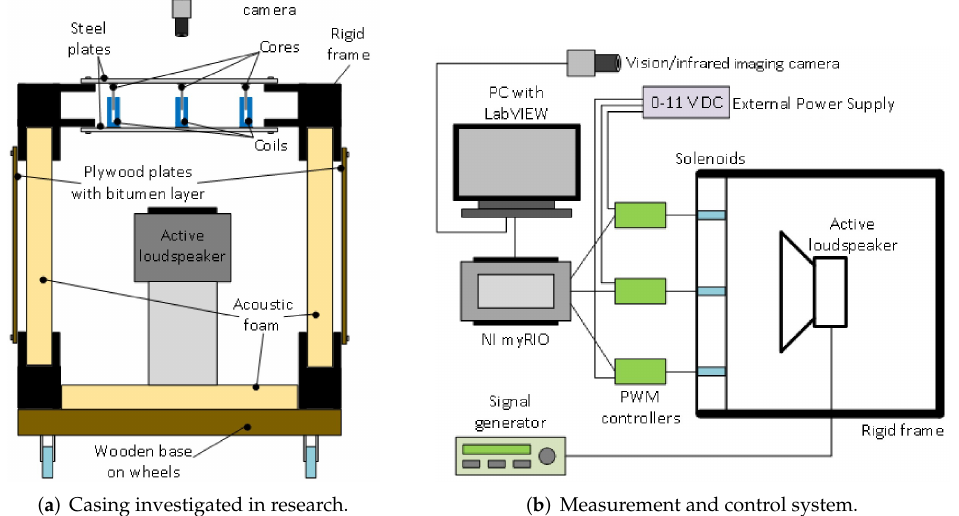
Figure 5. The schemes of laboratory